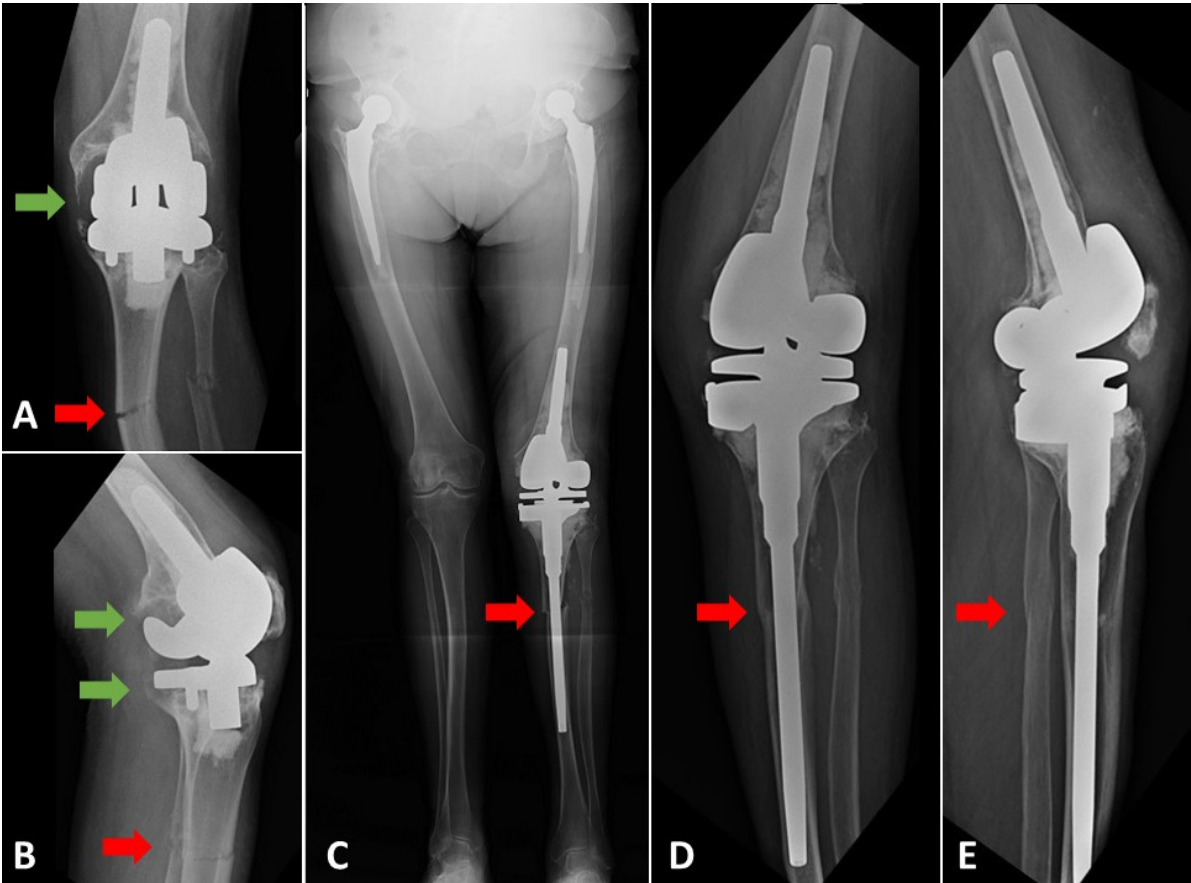
Figure 1. ( A ) AP and ( B ) lateral radiographs of a patient with the fracture of 1/3 proximal tibia and fibula shafts and loosened components of the knee prosthesis. ( C ) Postoperative, long-standing AP radiograph. Rotating-hinge revision knee prosthesis was used (MRH, Stryker, Mahwah, NJ, USA). ( D ) AP and ( E ) lateral radiographs of the same patient performed on the control visit 96 months after rTKA. Bone union was achieved. Green arrows indicate peri-implant bone osteolysis and loosening. Red arrows show the fracture level of the tibial shaft and bone union.